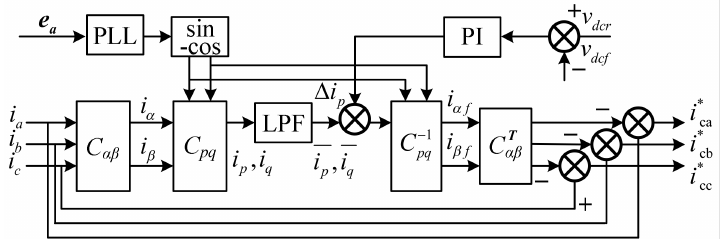
Figure 4. Block diagram for a simultaneous detection of the fundamental and higher harmonic reactive power